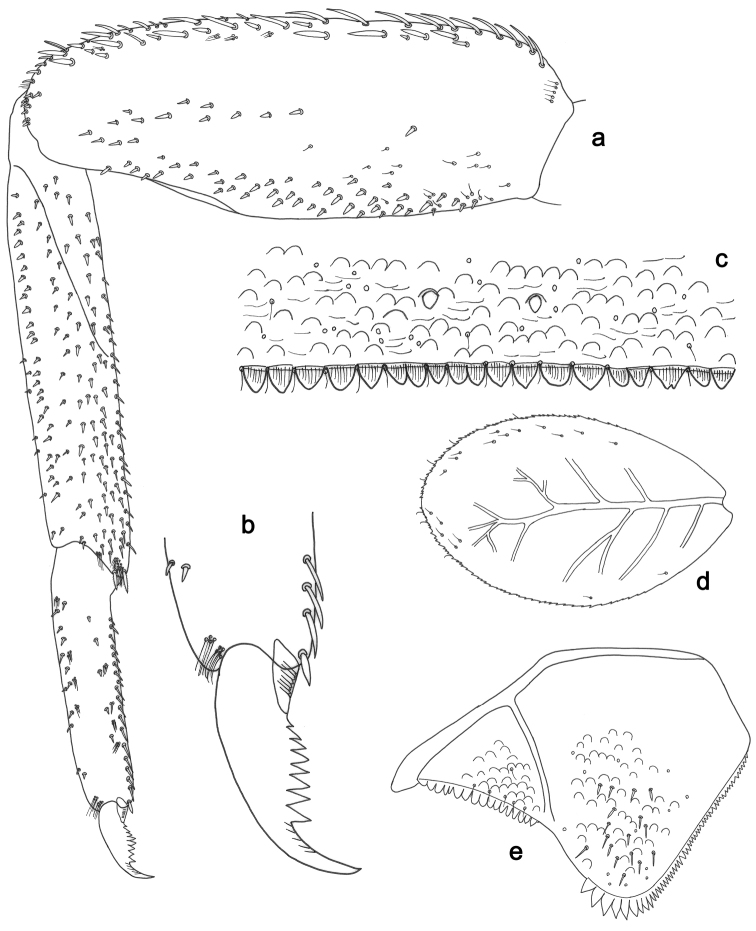
Labiobaetisschwanderae sp. n., larva morphology: aForelegb Fore claw cTergum IV d Gill IV eParaproct.